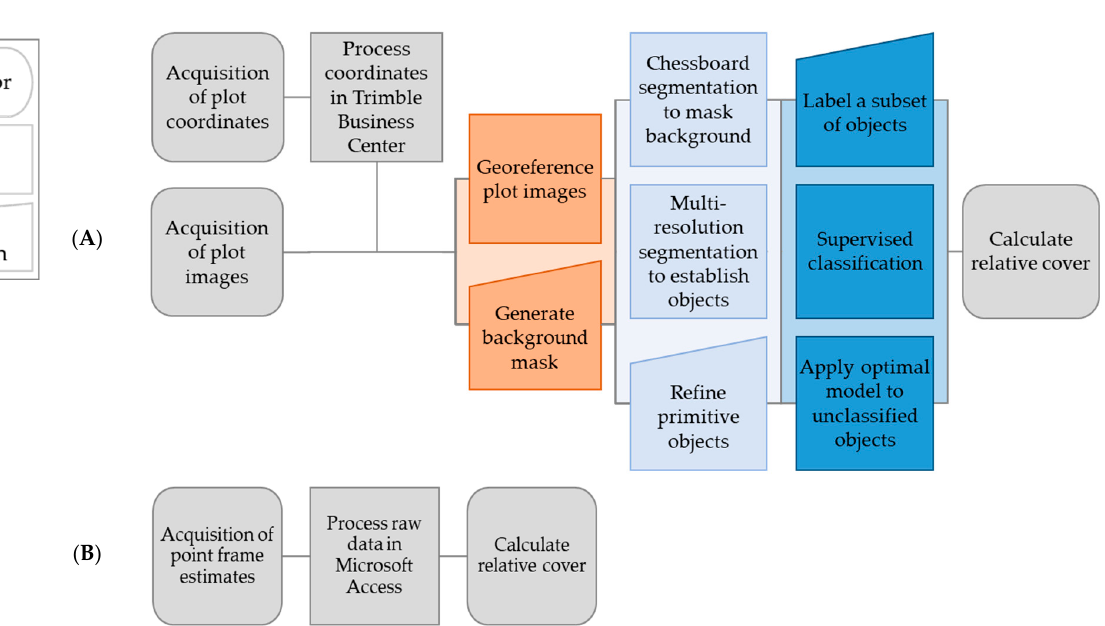
Figure 2. Schematic of the processing pipelines to estimate relative vegetation cover using ( A ) plot- level photography and ( B ) point frame field sampling methods. The steps to process the plot-level photographs were guided by semi-automated object-based image analysis: data acquisition, prepro- cessing images in ArcGIS Pro (orange), segmentation and preliminary classification in eCognition (light blue), and development and selection of a machine learning model in R (dark